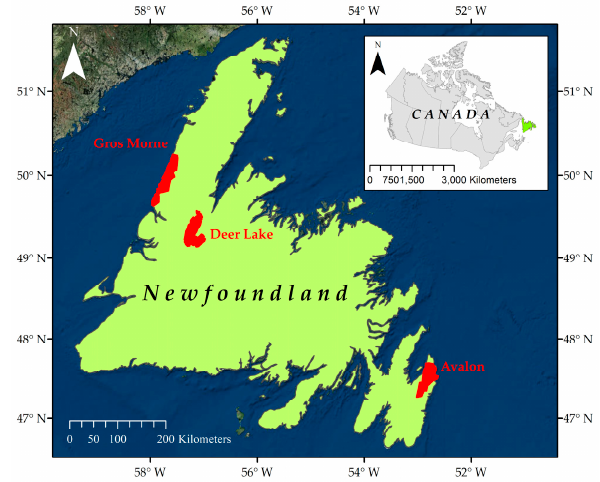
Figure 1. The red polygons illustrate the geographic location of the three study